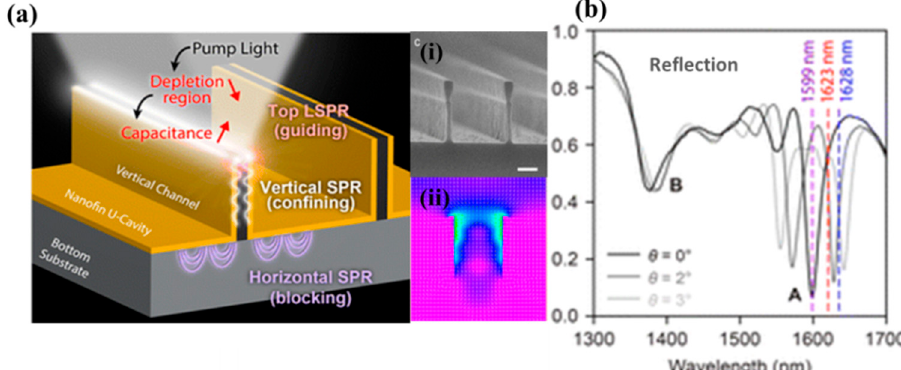
Figure 11. Three-dimensional plasmonic nanochannel/semiconductor structure. ( a ) Nanochannel/ semiconductor with U-shaped vertical plasmonic cavities structured at semiconductor substrate, ( i ) SEM image of Si channel fin on SiO 2 substrate, ( ii ) simulation of light concentration of EM radiations at right side; and ( b ) optical spectra showing the plasmonic coupled mode at different angles ( θ ) (Reproduced with the permission of [156], Copyright 2016, American Chemical Society).